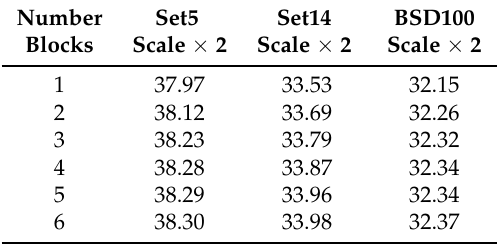
Table 4. Performance comparison of network with different numbers of